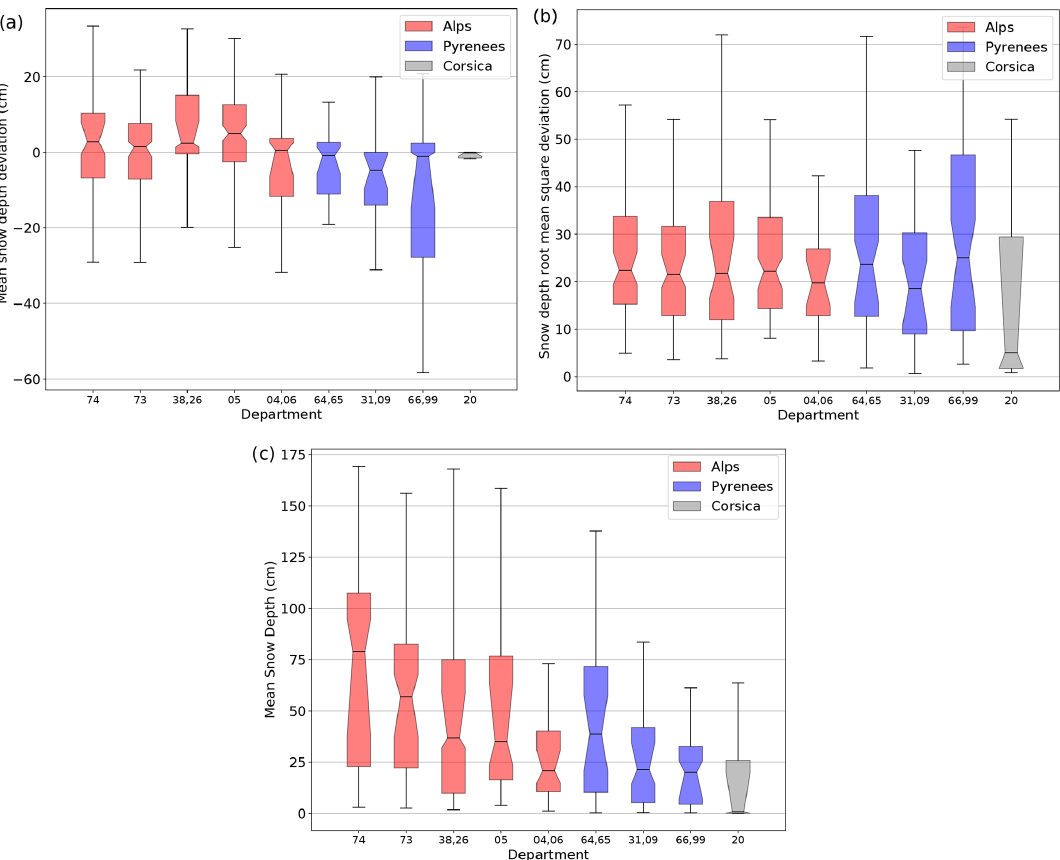
Figure 14. Mean deviation and root mean square deviation between the simulated and observed snow depths values and mean simulated snow depth on the 665 evaluation sites grouped by administrative departments. Department numbers 73 and 74 correspond to the Northern Alps; 38, 26 and 05 correspond to the Central Alps; 04 and 06 correspond to the Southern Alps; 64 and 65 correspond to the Western Pyrenees; 31 and 09 correspond to the Central Pyrenees; 66 and 99 correspond to the Eastern Pyrenees; and 20 corresponds to Corsica. See Fig. 2 and Table A1 for more